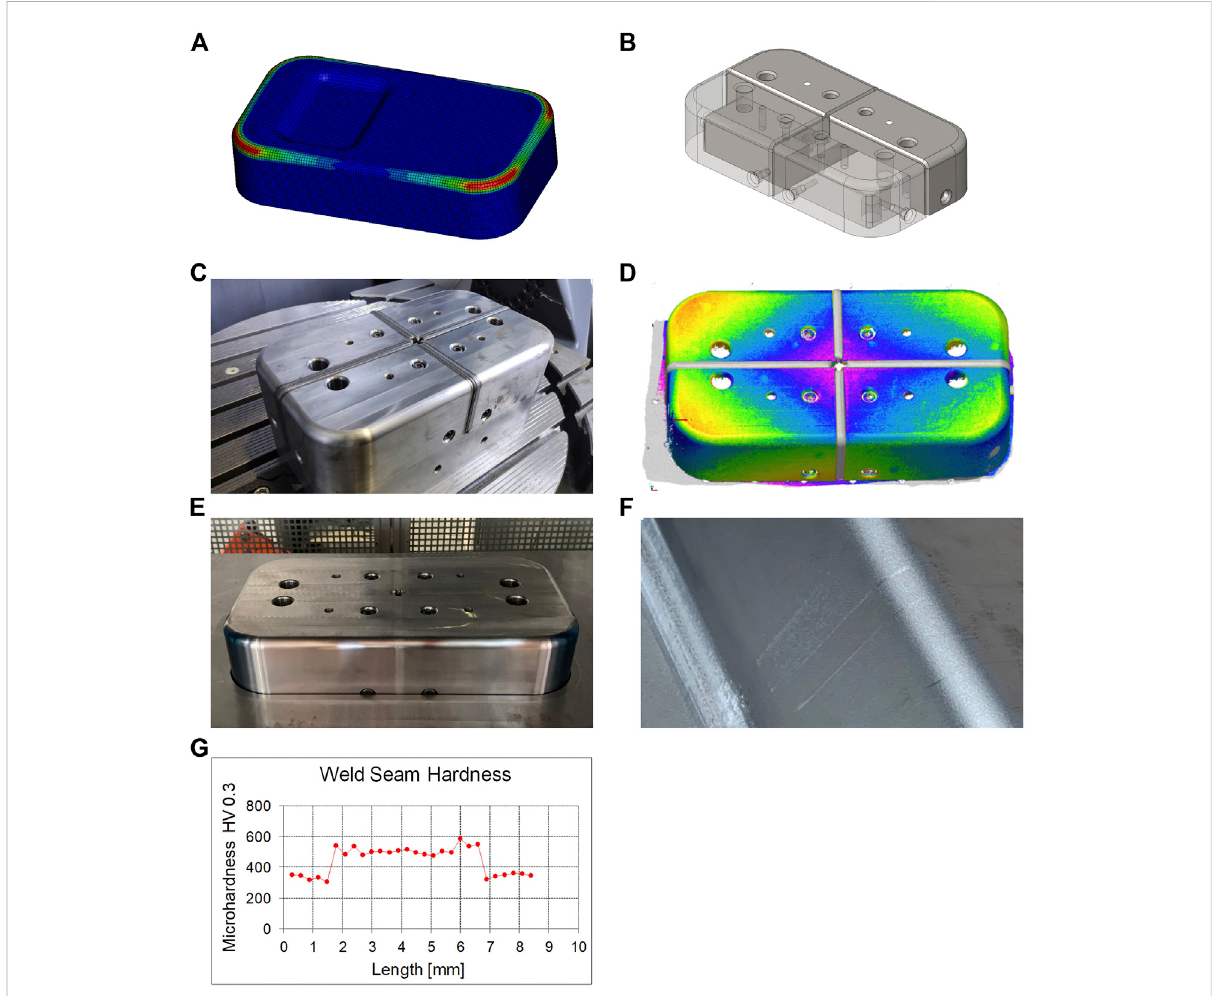
FIGURE 4 Segmented manufacturing of a deep drawing stamp: (A) FEA of the deep drawing process, (B) segmented part that consist out of (inner) core- and(outer)shell-segmentsassembled via screwconnections, (C) assembledandweldedstamp, (D) distortionofthestampaftertheweldingprocess, (E) fi nished stamp, (F) marks from the weld seams on the sheet after deep drawing, (G) hardness measurement of the seam and the heat affected